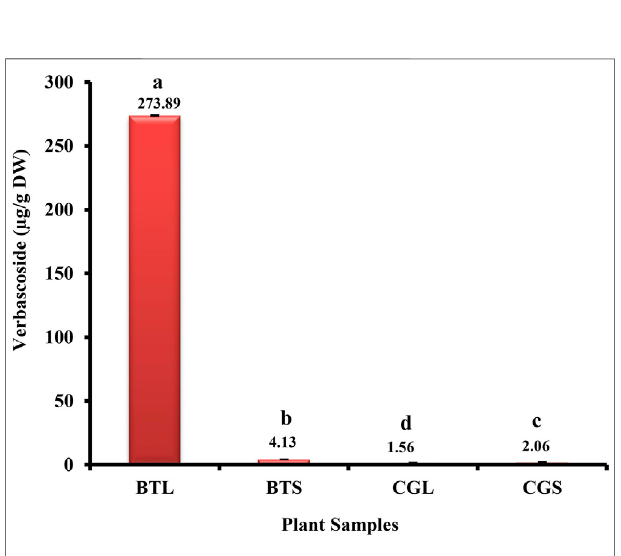
FIGURE 5 | HPLC analysis of verbascoside from B. terminalis and C. grandi fl orus . BTL — B. terminalis leaves, BTS — B. terminalis stem, CGL — C. grandi fl orus leaves, CGS — C. grandi fl orus